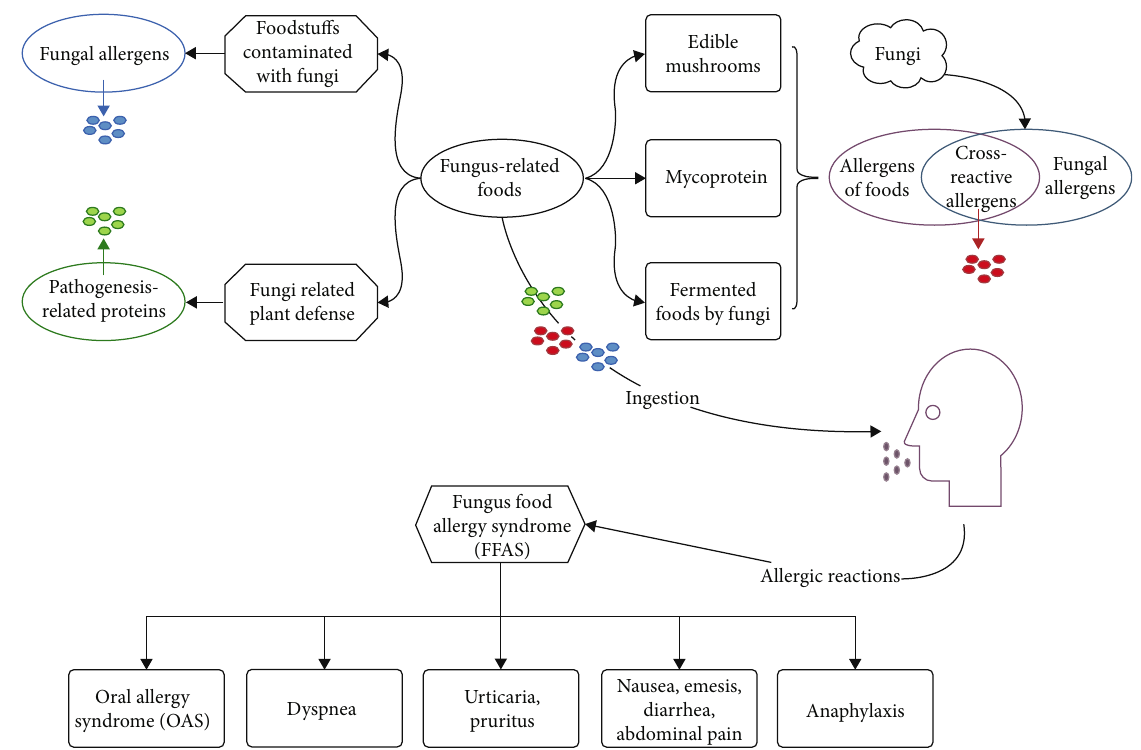
Figure 1: Schematic diagram of FFAS after ingestion of fungus-related